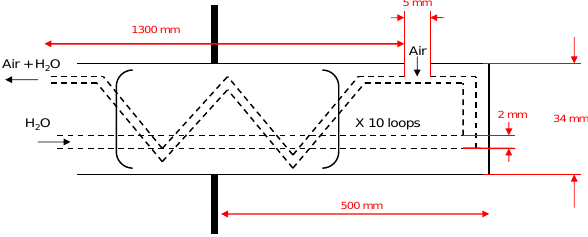
Fig. 2. Sketch of the sampling line not scaled. The thick bars indi- cate the CLOUD chamber wall. Red color gives the dimensions of the sampling